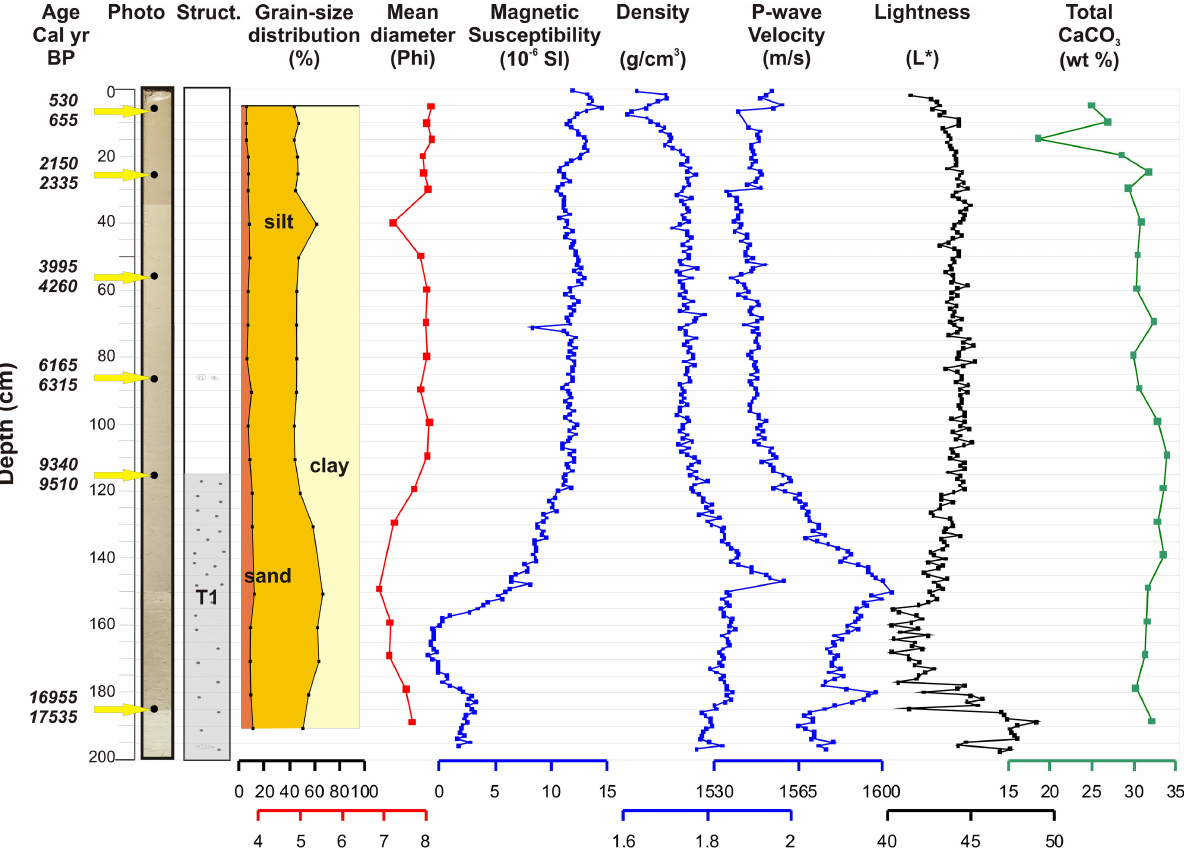
Fig. 5. Image, lithological description, grain-size distribution, mean diameter, magnetic susceptibility, density, P-wave velocity, lightness, total calcium carbonate and calibrated ages of CIM-4 sediment core. T1 refers to a mud-rich turbidite interval. Table 1. Location of the studied core, radiocarbon AMS data and sample age calibrations based on the Marine09 curve (Reimer et al., 2009) included in Calib 6.1 calibration